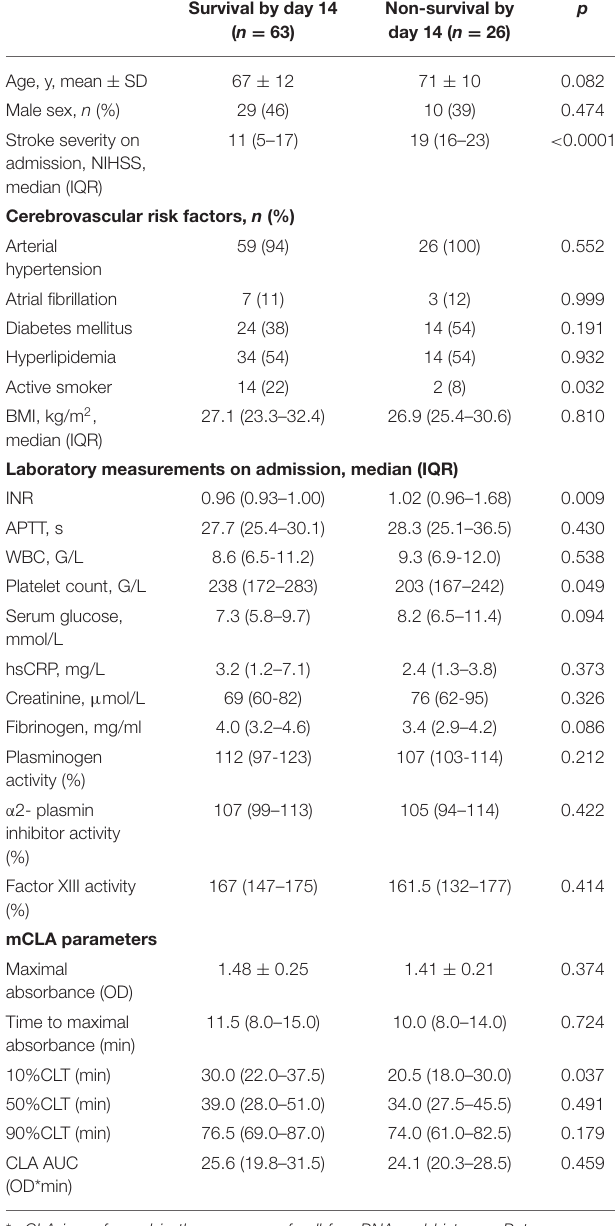
TABLE 3 | Baseline clinical data and modified clot lysis assay (mCLA)* parameters according to mortality by day 14. Survival by day 14 ( n =